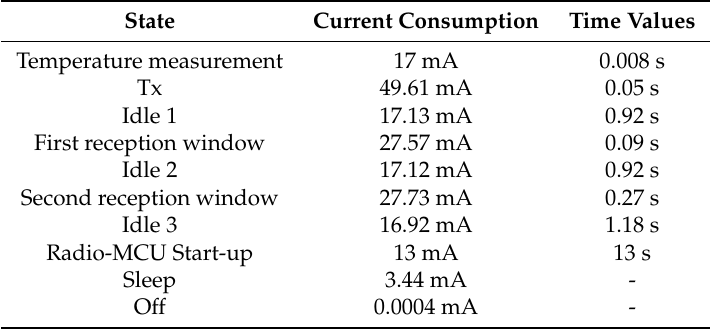
Table 1. Current consumption and time values of SODAQ ExpLoRer